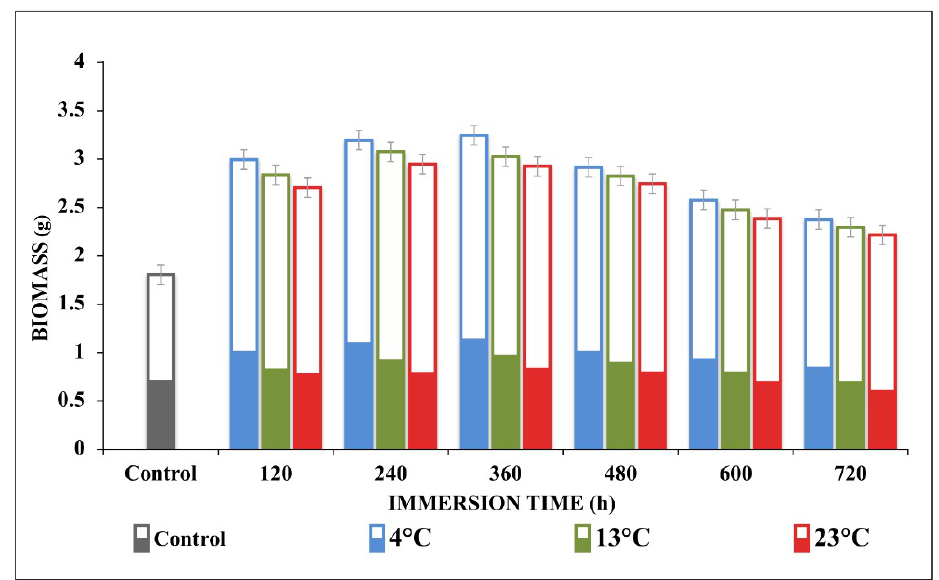
S.E.). The shaded portion of ±